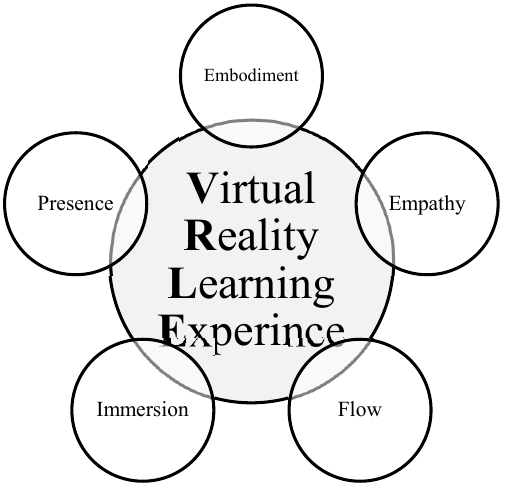
Figure 2. The hedonic qualities of a VR learning experience.